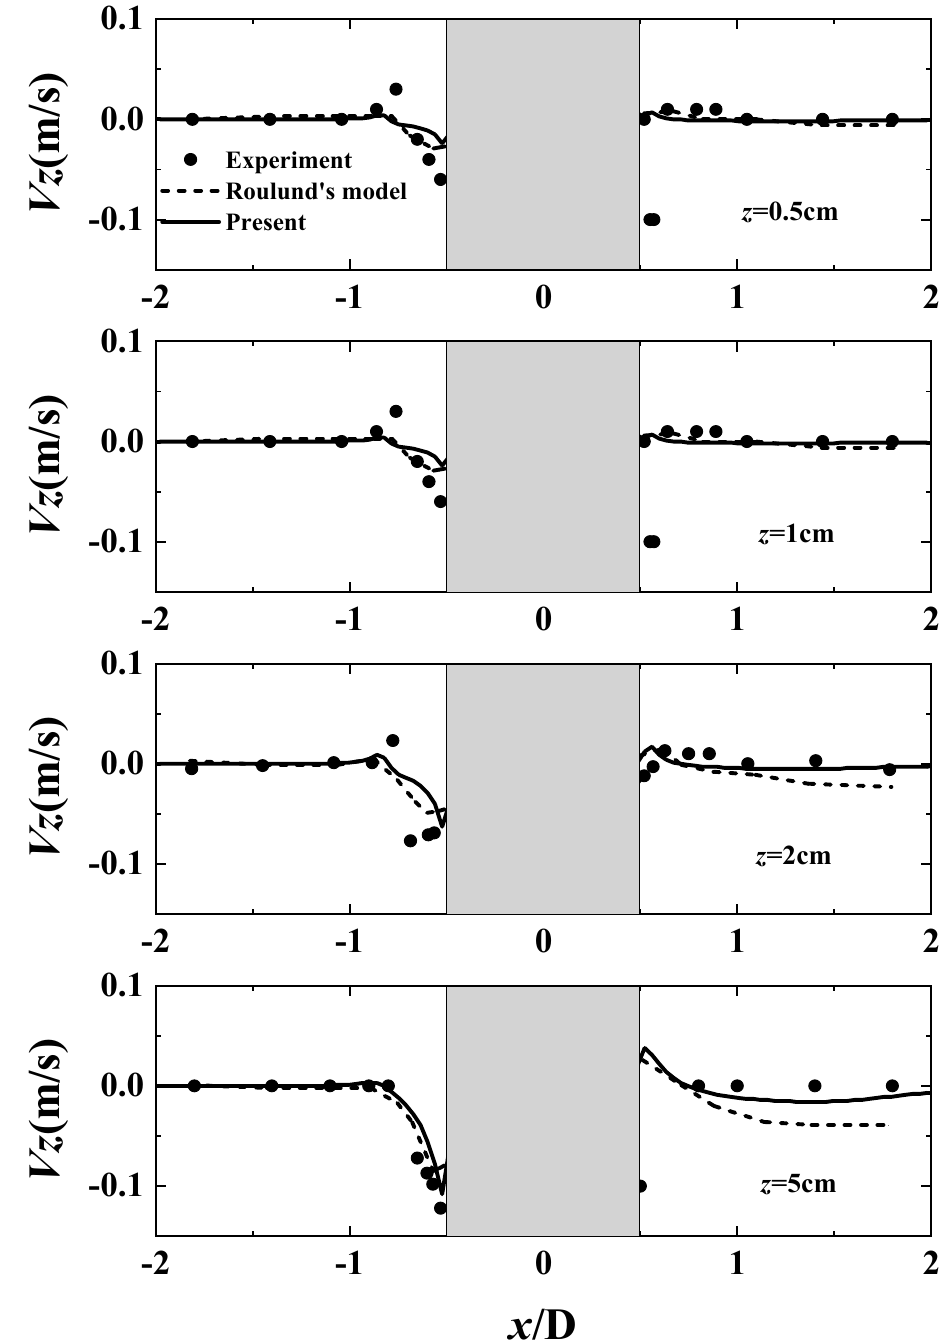
Figure 3. Distribution of vertical velocity ( Vz ) in symmetry plane ( y = 0 m) at different distances from the bed.